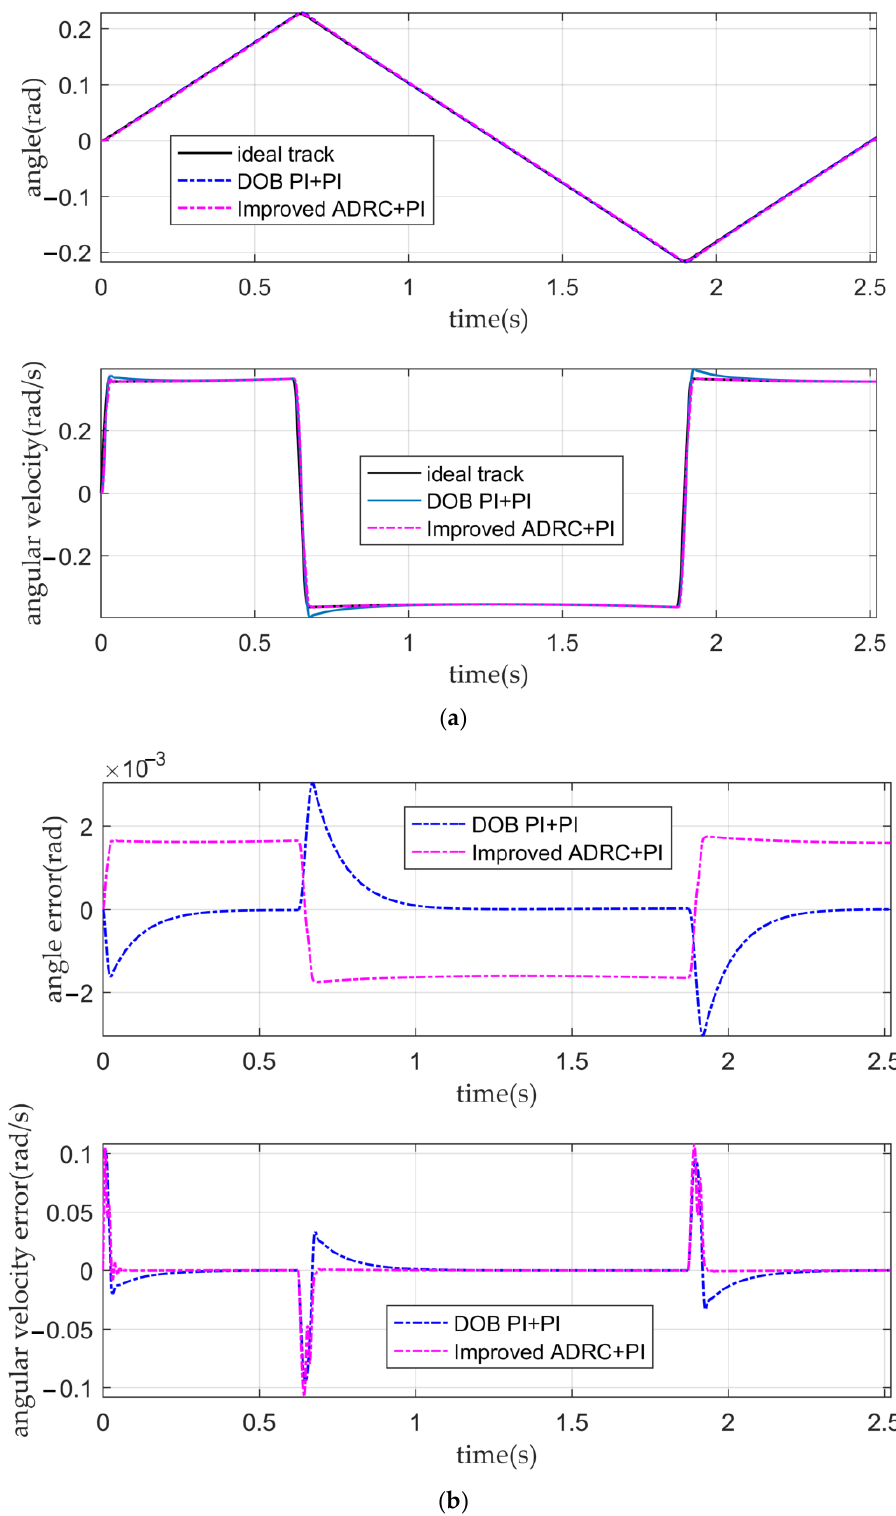
Figure 12. The tracking curves and the error curves. ( a ) The angular displacement tracking curves and the angular velocity tracking curves of the PI double closed-loop controller based on DOB and the IADR-DCLC; ( b ) the angular displacement error curves and the angular velocity error curves of the PI double closed-loop controller based on DOB and the